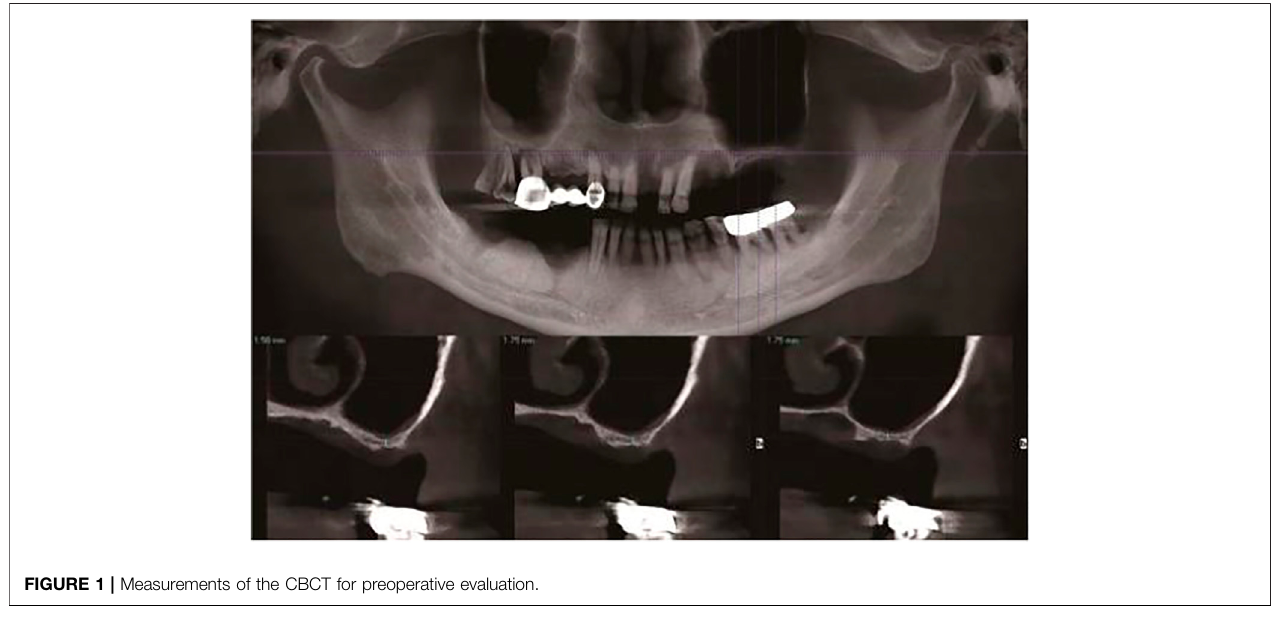
FIGURE 1 | Measurements of the CBCT for preoperative evaluation.